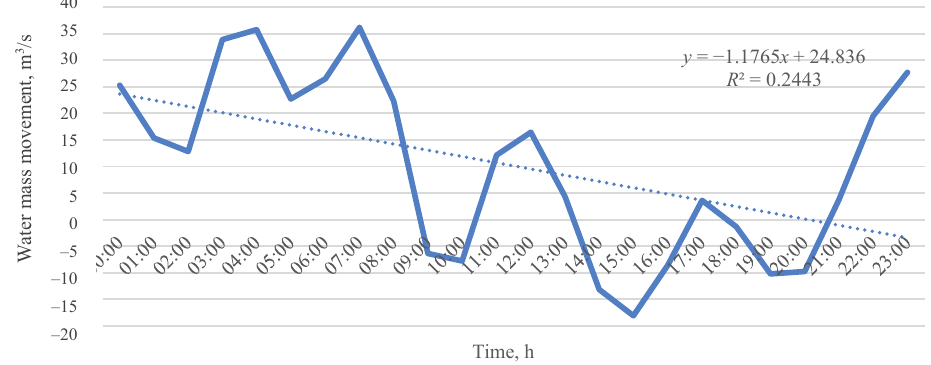
Fig. 3. Hourly changes in water mass movement for 2017–2021 at the observation station ‘Riga’. Fig. 4 shows the water mass movement data on an hourly time scale. 18.09.2020 is the day with the highest average value, while 26.10.2017 is the day with the lowest average value. 13.03.2020 is the day with the highest maximum value. 18.07.2018 is the day with the lowest maximum value. 27.09.2019 is the day with the maximal lowest value. 31.01.2018 is the day lake can change and how vulnerable is Lake